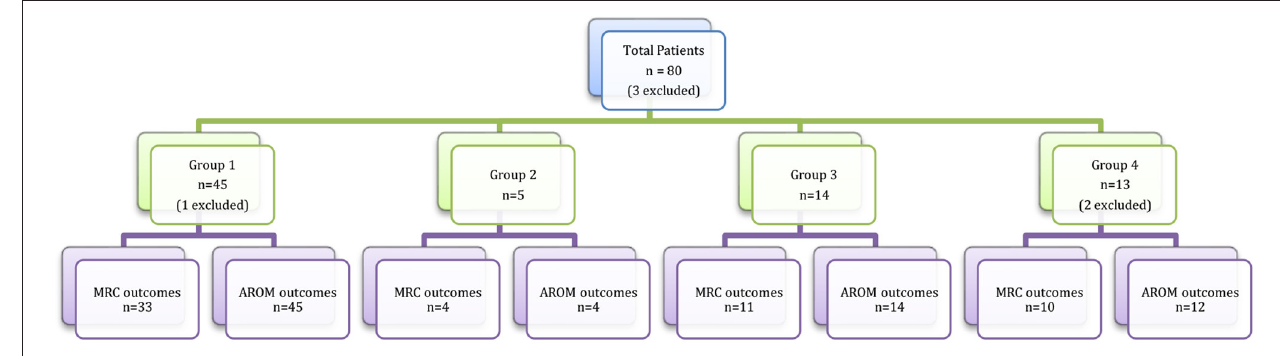
FIGURE 2 | Total and subgroup patient numbers for outcome analysis.